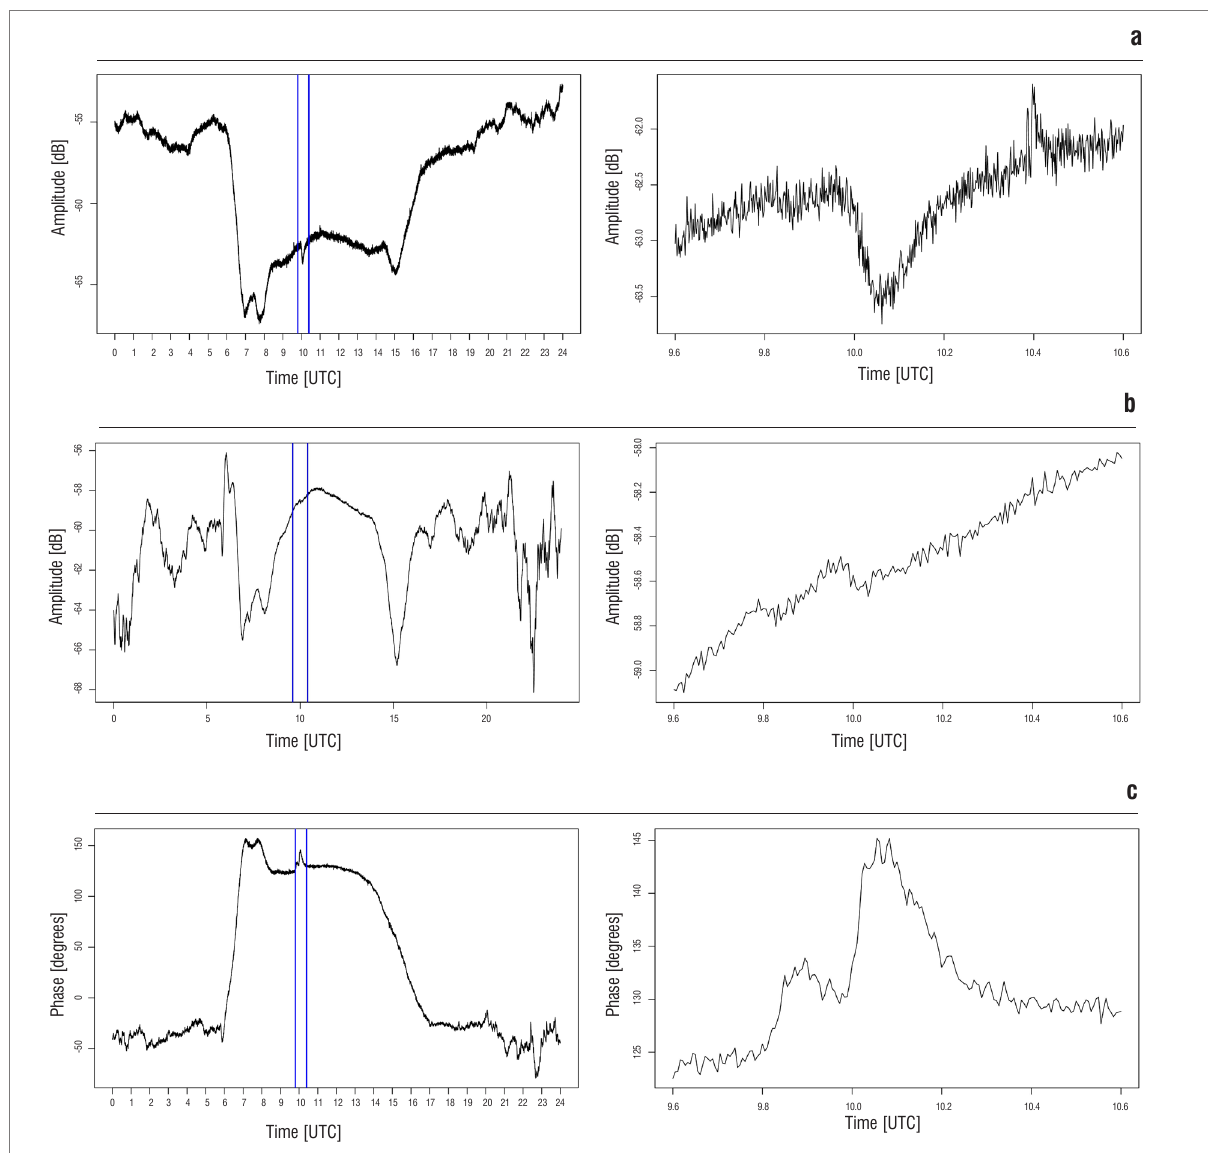
Figure 4: Signals recorded at Budapest for (a) GBZ (amplitude), (b) GQD (amplitude) and (c) GQD